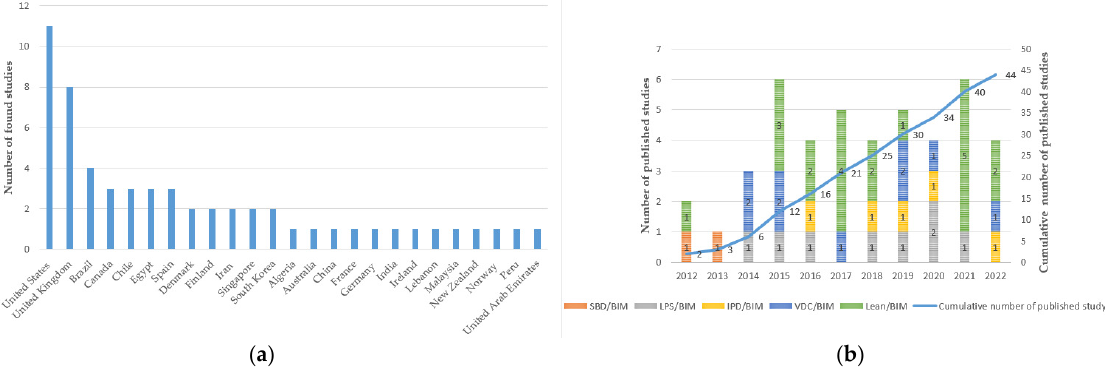
Figure 2. Contribution of countries to the obtained articles ( a ) and their annual distribution from 2012 to 2022 ( b ).